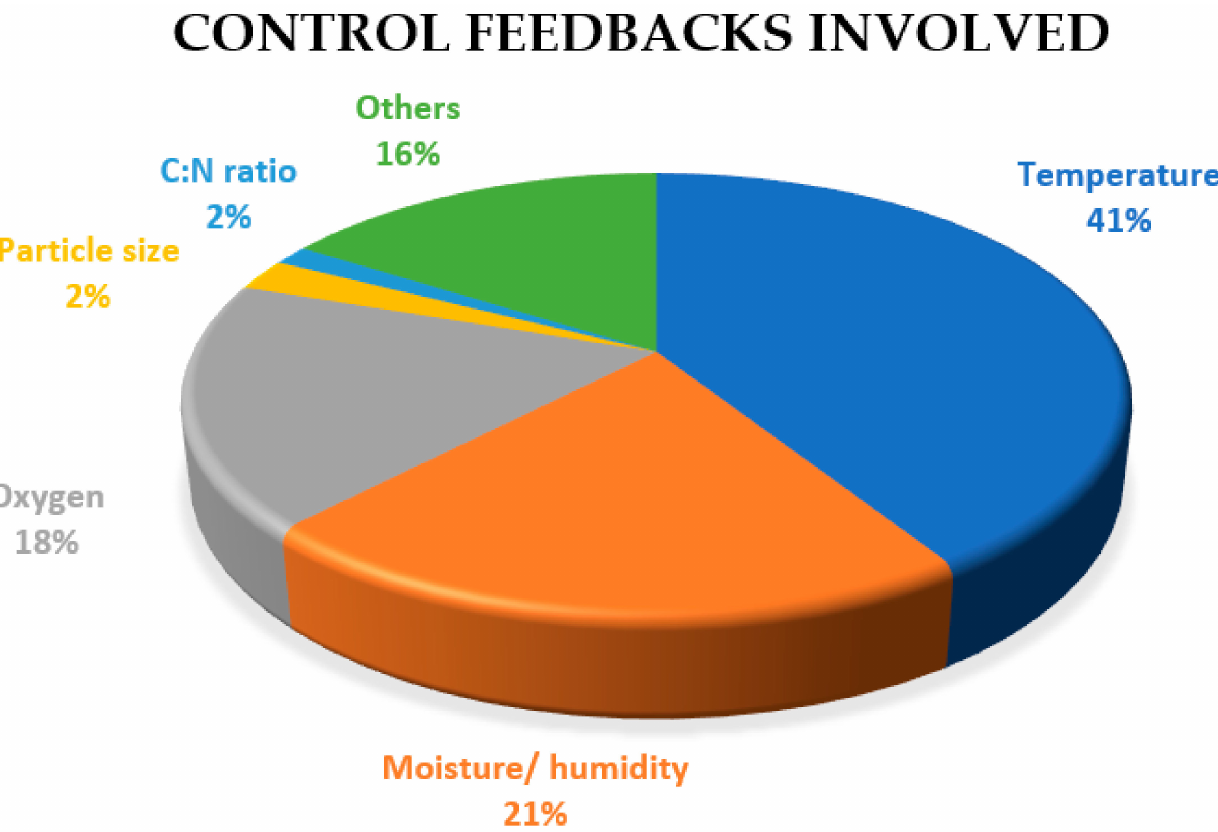
Figure 17. Control feedbacks involved within the selected